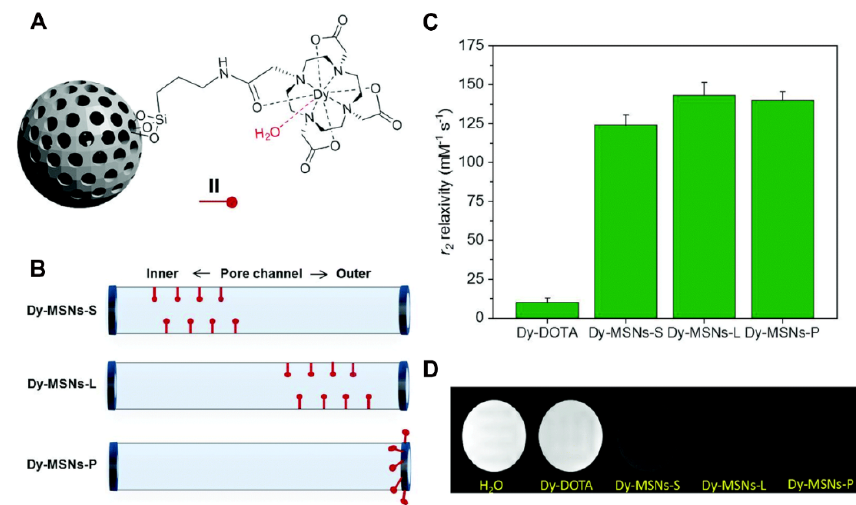
Figure 5. A figure detailing how the position of paramagnetic chelates within MSNs affects the relaxivity ( r 2 ) values. ( A ) General schematic of Dy-MSNs. ( B ) The different available locations for the tethered Dy-chelate. S, L and P refer to the synthetic procedure i.e., short-delay, long-delay and post-grafting, respectively. ( C ) Associated relaxivity values where the highest relaxivity can be observed for Dy-MSNs-L with r 2 = 143.5 ± 8.2 mM − 1 s − 1 at 11.7 T. All three locations show substantially improved r 2 in comparison to native molecular Dy-DOTA. ( D ) MRI phantoms characterising the response of the system. Adapted with permission from reference [80]. Copyright (2018) The Royal Society of Chemistry.